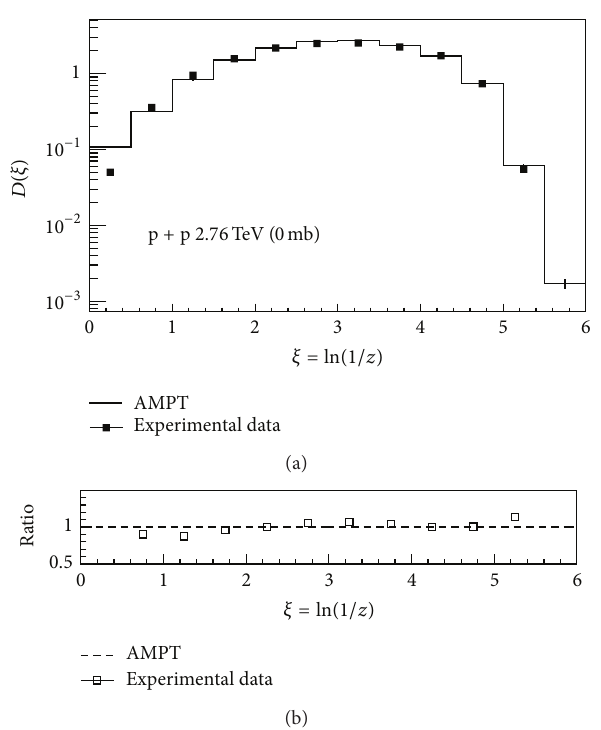
Figure 5: (a) The jet fragmentation function 𝐷(𝜉) in p + p collisions at √𝑠 𝑁𝑁 = 2.76 TeV, where the histograms represent the AMPT (0mb) result with hadronic interactions only and the squares represent the data from the CMS experiment [14]. (b) The ratio of AMPT result to experimental data.